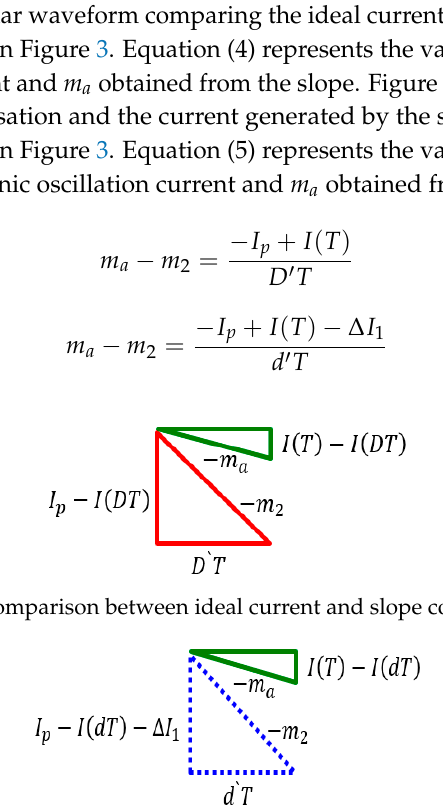
Figure 7. Comparison between sub-harmonic oscillation current and slope compensation.